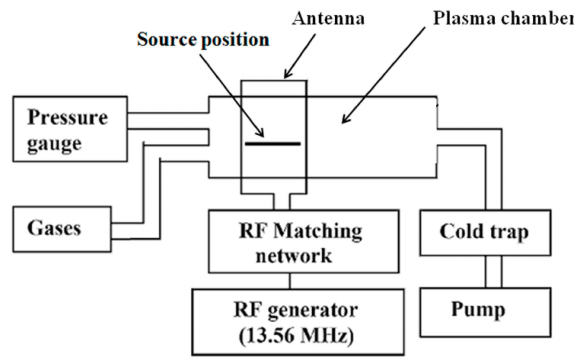
Figure 11. Schematic diagram of treatment chamber for gas plasma